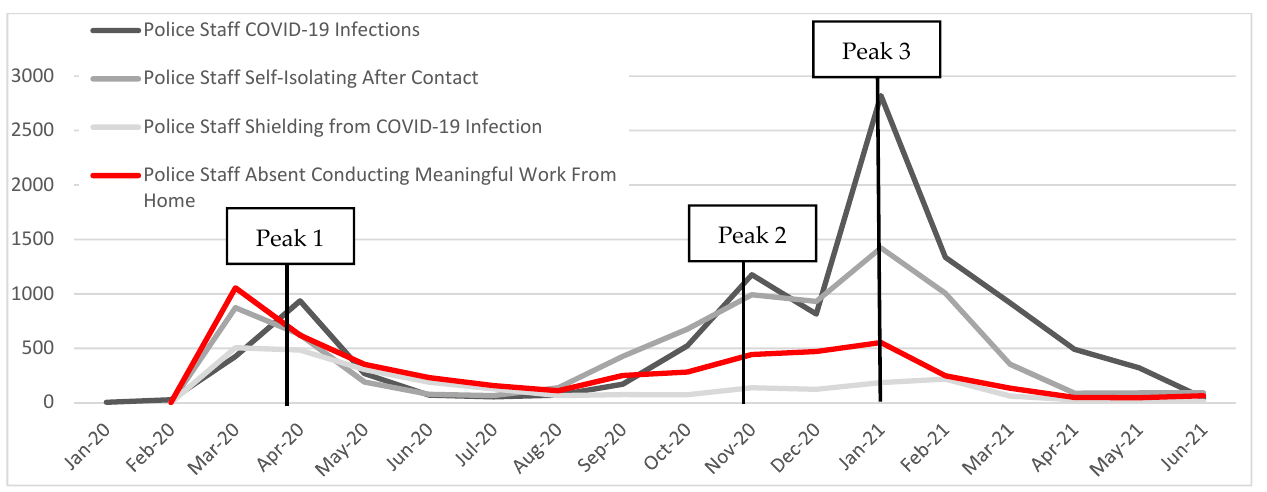
Figure 5. Reported police staff absences and peak infection periods vs. Police staff conducting meaningful